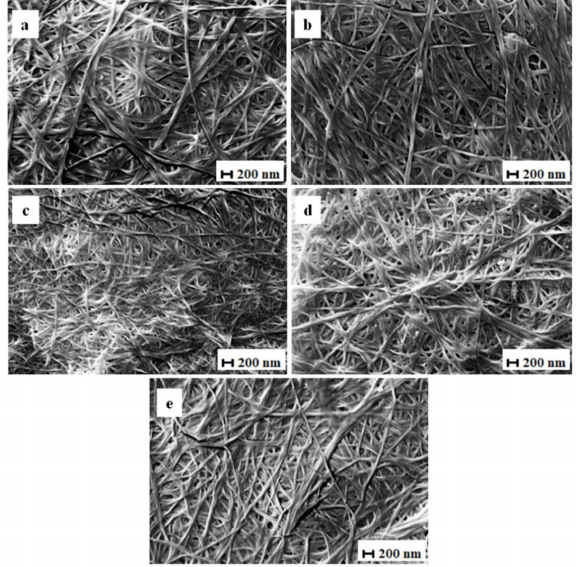
Figure 9. SEM images of dry BC. ( a )—i1d6; ( b )—i5d6; ( c )—i1d18; ( d )—i5d18; ( e )—i3d12; i—inoculum, d—harvest day; the number following “i” stands for inoculum volume 1, 3, 5 mL and the number following “d” represents the harvest day 6, 12, 18 days. (electron high tension (EHT) = 10.00 kV; magnitude (Mag) = 10.00 KX; working distance (WD) = 7.0 mm; Signal A =